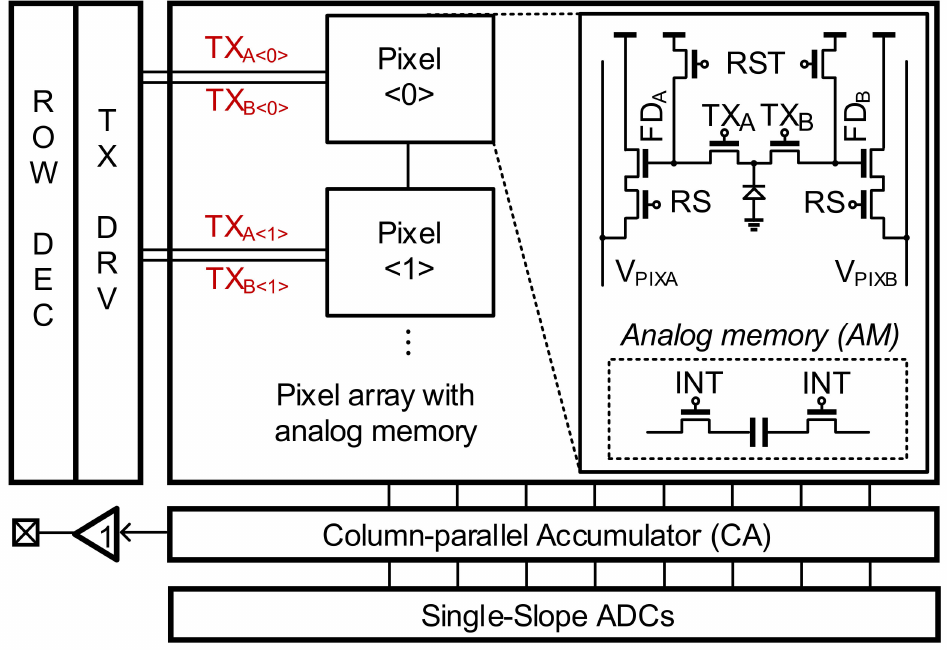
Figure 5. Overall architecture of the